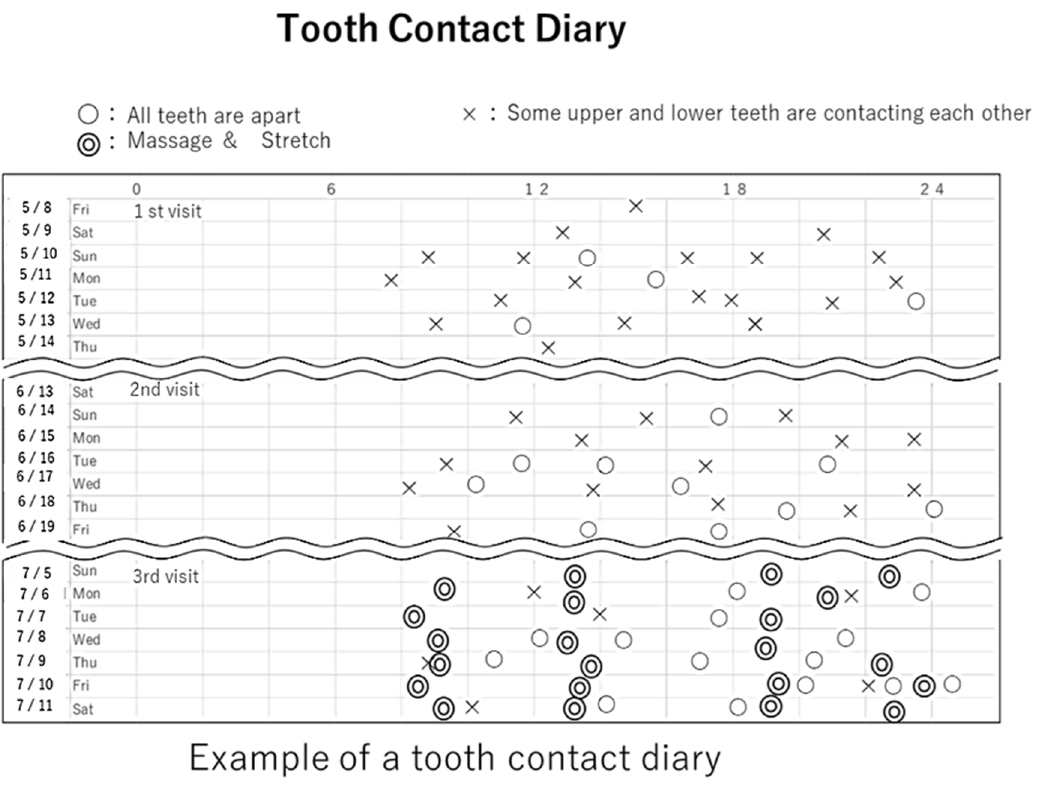
Figure 2. The contact status of the upper and lower teeth.